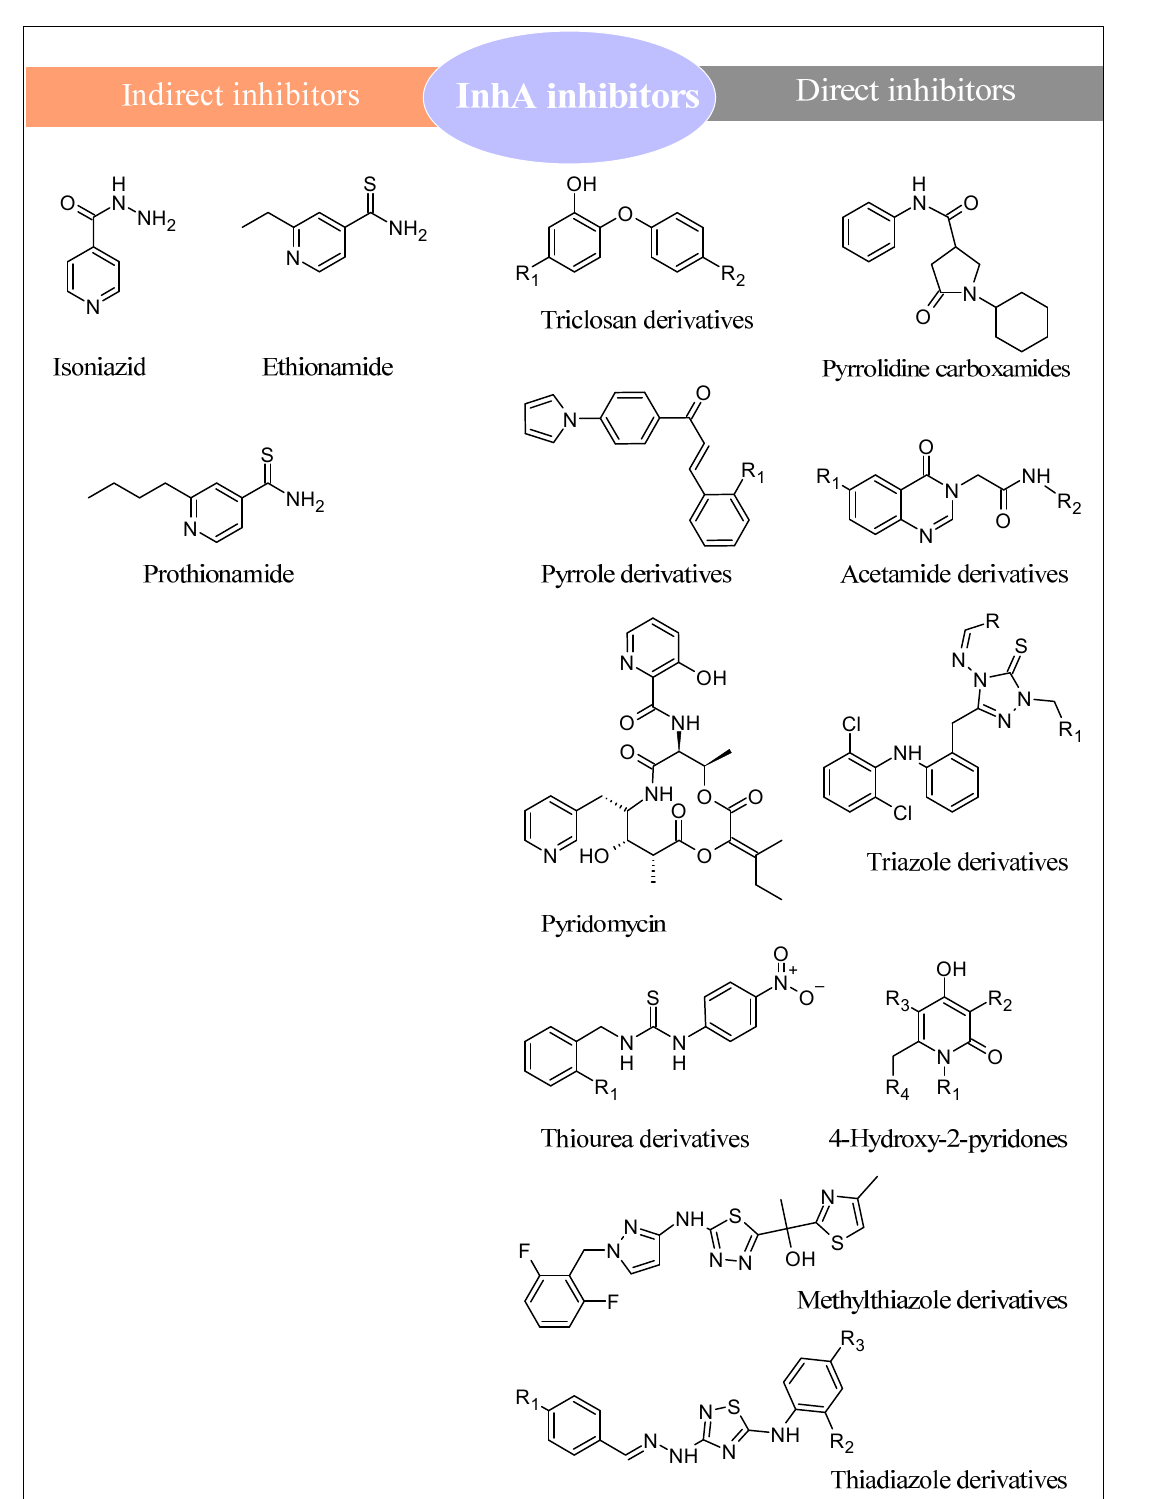
Figure 1. Direct and indirect InhA inhibitors, as described in the literature [5–8].